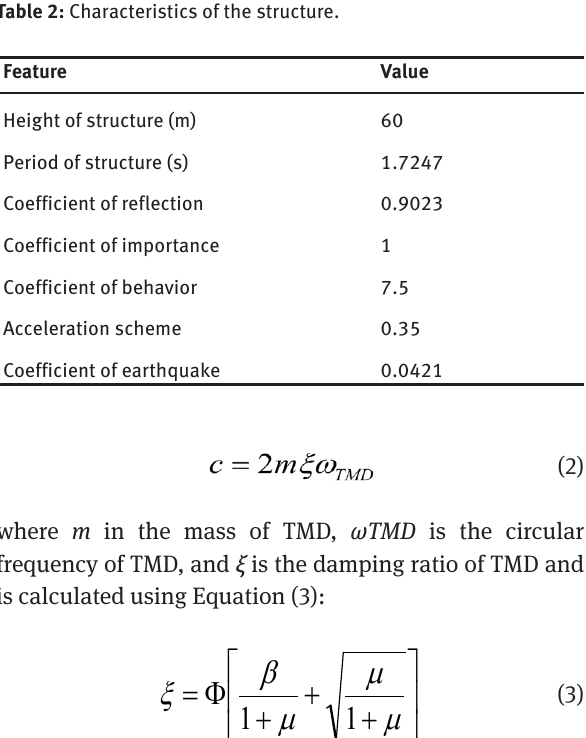
Table 2: Characteristics of the